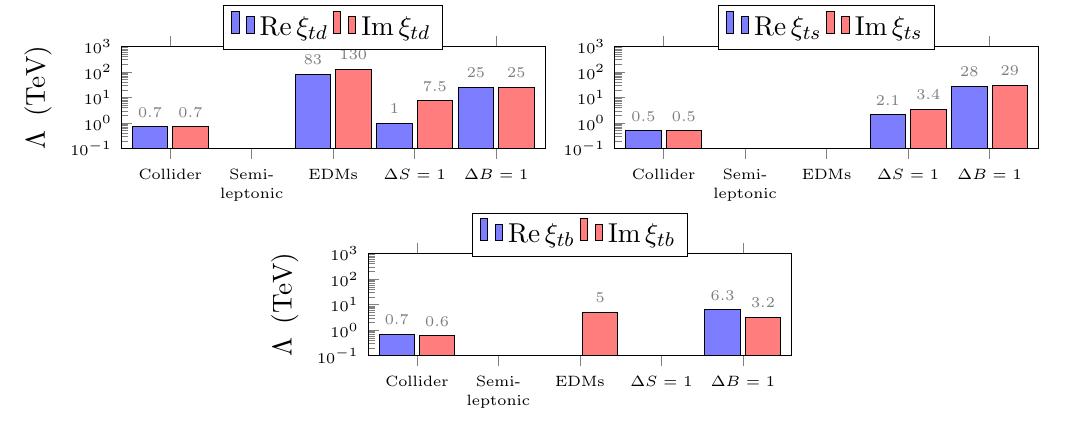
Figure 9 . The (cid:12)gure shows naive constraints on (cid:24) td , (cid:24) ts and (cid:24) tb . Notation is the same as in (cid:12)gure 6. As shown in eq. (8.1), in the case of cb , our (cid:12)t prefers a non-zero value of Re (cid:24) , while for the cb ub element, both real and imaginary part are compatible with zero. The reason being that the nonzero values of (cid:24) that are preferred by the semileptonic decays are disfavored by the ub neutron EDM. We caution though that our analysis of the inclusive decays is incomplete, and, in particular, we did not repeat the (cid:12)ts to the lepton spectrum, which receive di(cid:11)erent contributions from left- and right-handed currents. We notice that the bounds on (cid:24) and ub Im (cid:24) are rather weak when compared to the magnitudes of V and V , and sizable right- cb ub cb handed corrections (up to 50% for V and 30% for V ) are still ub cb